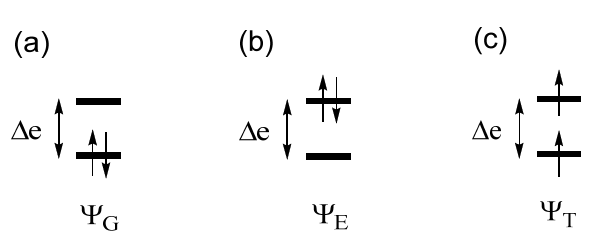
Figure 2. Three configurations critical for determining the energy difference between the singlet and triplet states of a dimer. ( a , b ) The two singlet-state configurations. ( c ) The triplet-state configuration.